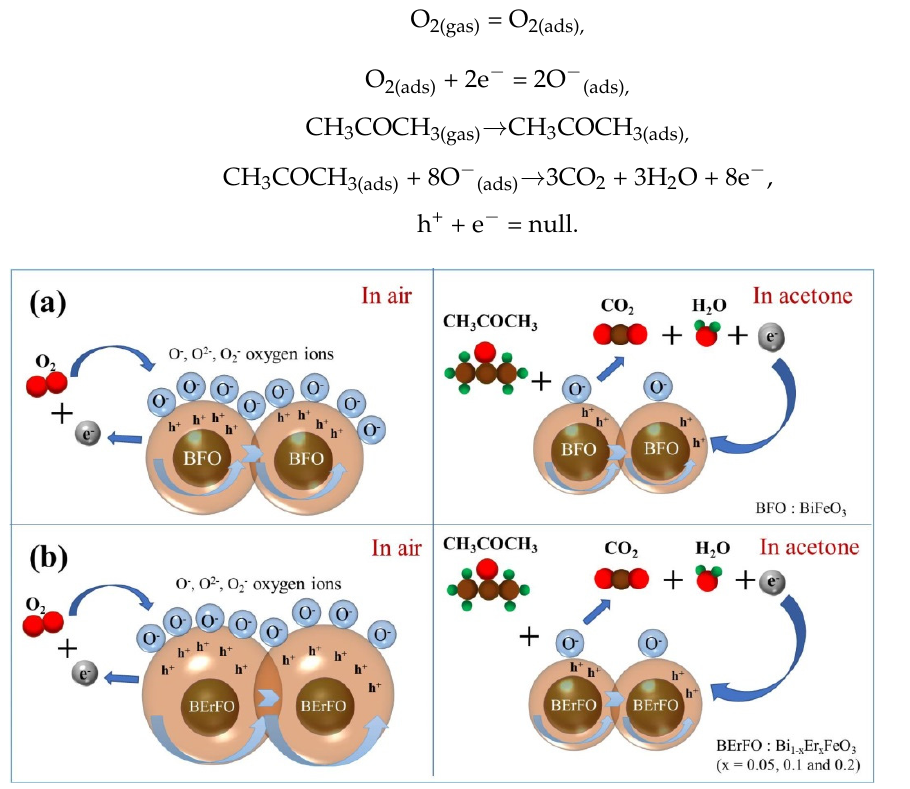
Figure 8. The illustration of the gas-sensing mechanism of Bi 1 − x Er x FeO 3 sensors: ( a ) x = 0, ( b ) x = 0.05, 0.1, 0.2.